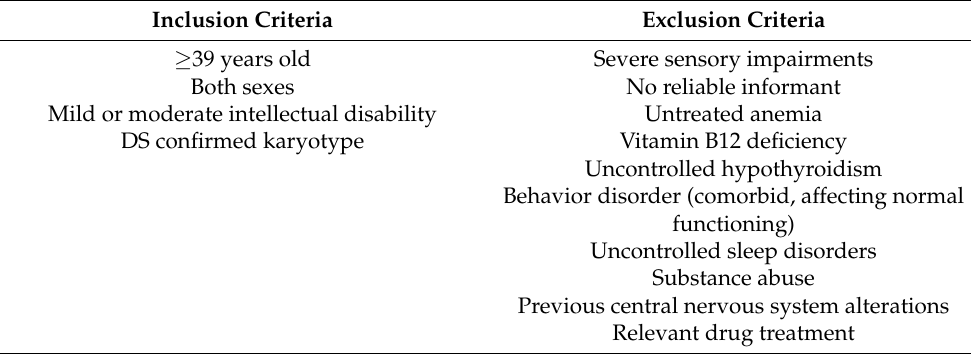
Table 1. Inclusion and exclusion